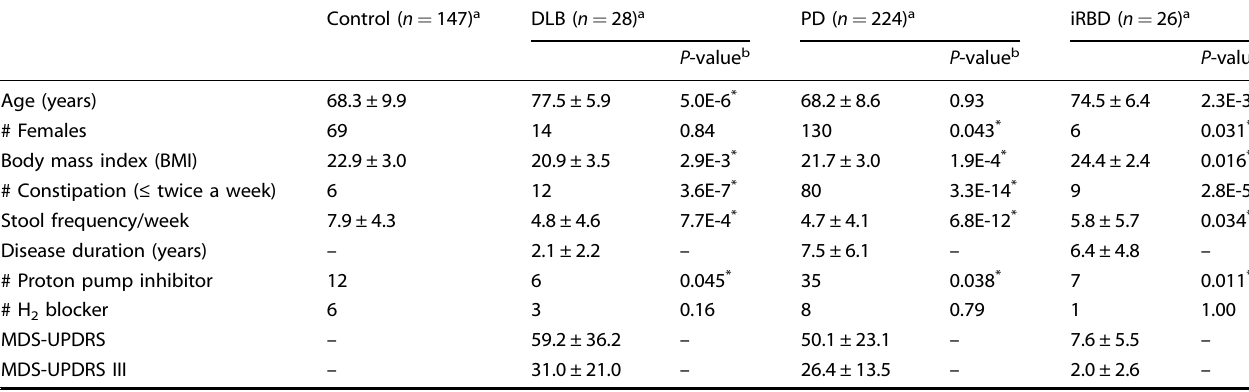
Table 1. Clinical and demographic features of controls, DLB, PD, and iRBD